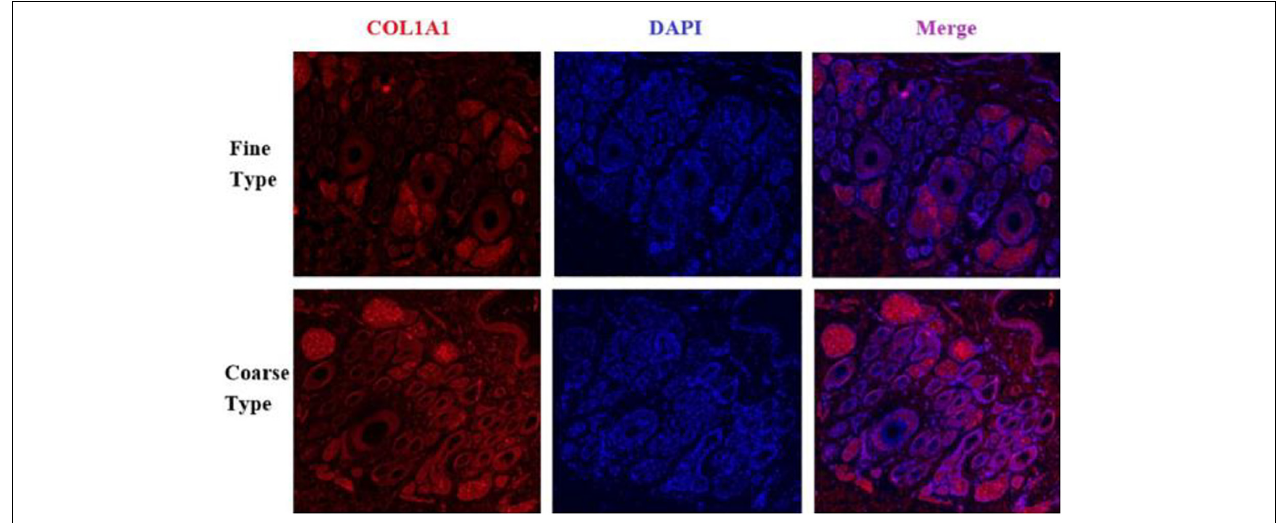
FIGURE 12 | IF results of COL1A1 in FT-LCG and CT-LCG skin tissues